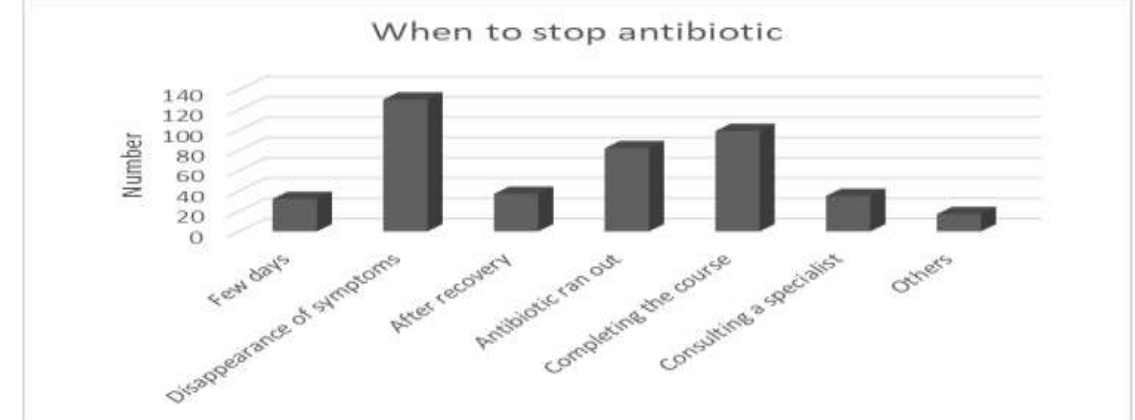
Figure 6. When to stop antibiotic More than two-thirds of the participants (72.9%) have suffered from some type of adverse reaction to the antibiotics during usage. The main response when this happened was to stop the antibiotic